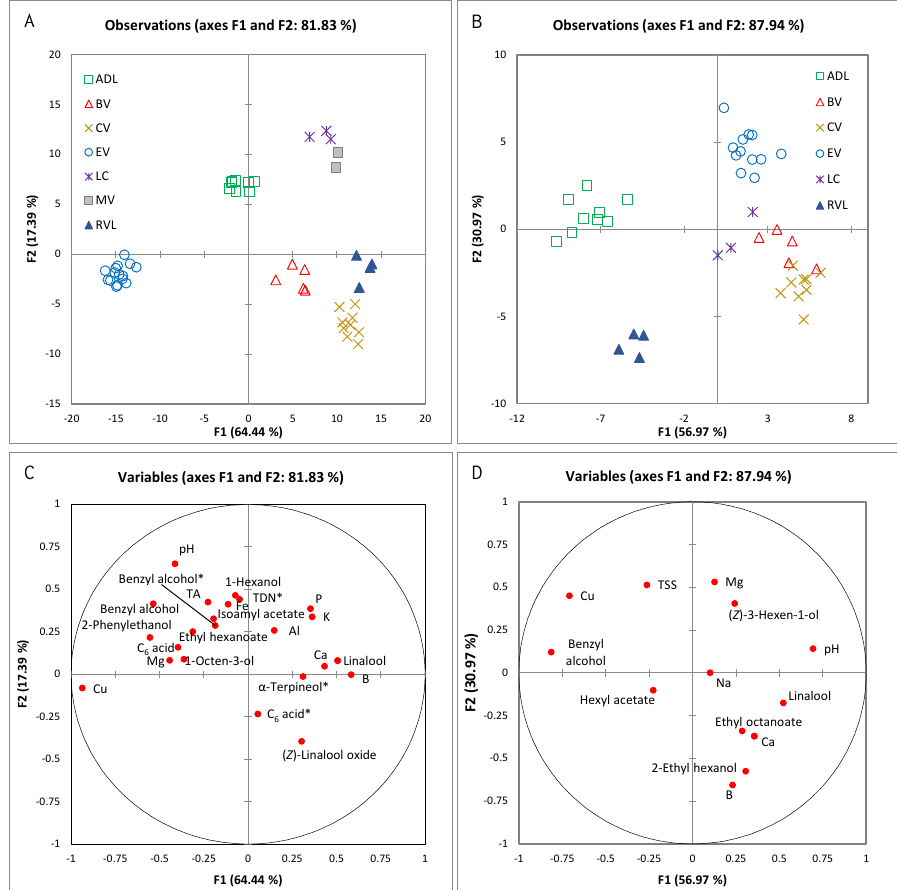
Figure 3 Figure 3. Distribution of grape samples in the two coordinate system defined by discriminant analysis showing the two canonical variables with the highest discrimination power. Scores projected onto F1 and F2 for 2015 ( A ) and 2016 ( B ) show samples grouped according to GI where ADL, Adelaide Hills; BV, Barossa Valley; CV, Clare Valley; EV, Eden Valley; LC, Langhorne Creek; MV, McLaren Vale; RVL, Riverland. Loadings of variables used in the analysis are shown for 2015 ( C ) and for 2016 ( D ) where * denotes volatiles detected after hydrolysis of glycosides extracted from juice. Abbreviations (e.g., TSS, TDN) are the same as specified in the